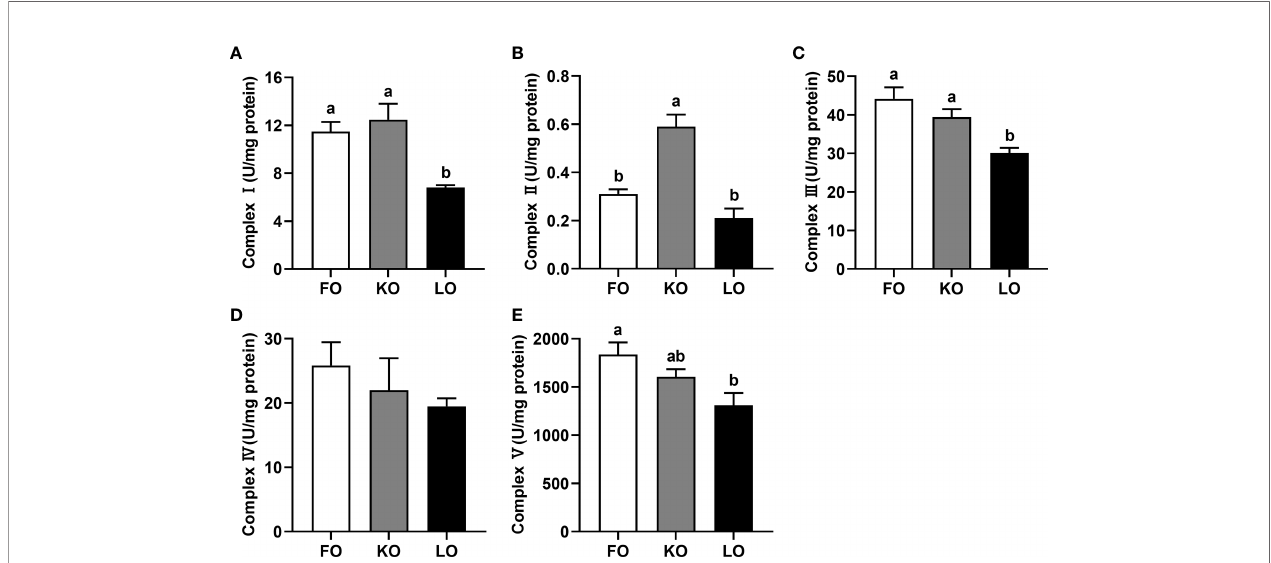
FIGURE 3 | Effects of dietary n-3 PUFA lipid sources on activities of mitochondrial electron transport chain complexes in the hepatopancreas of swimming crab. Values are mean ± SE (n = 4). Bars with different superscripts represent signi fi cant difference by one-factor ANOVA followed by a Tukey ’ s multiple range post-hoc test (P < 0.05). (A) Complex I; (B) Complex II; (C) Complex III; (D) Complex IV; (E) Complex